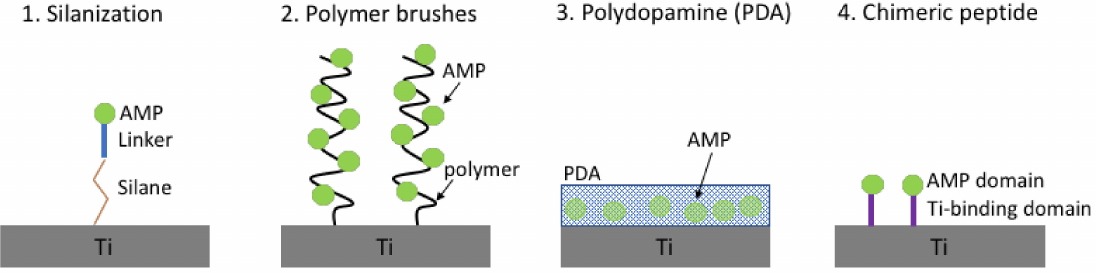
Figure 3. Covalent immobilisation of AMPs on titanium